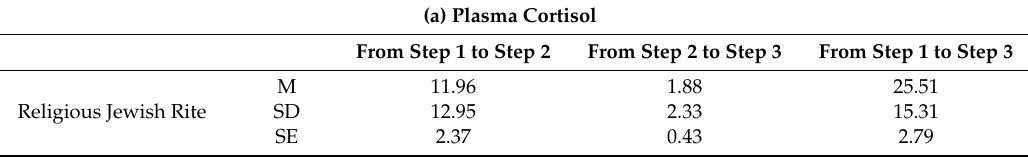
Table 2. Mean values (M), Standard Deviation (SD) and Standard Error (SE) of the increase rates among the three steps. M from step 1 to step 2 expresses the difference between the parameter recorded in steps 2 and 1, divided by the level found in step 1. M from step 2 to step 3 expresses the difference between the parameter recorded in steps 3 and 2, divided by the level found in step 2. M from step 1 to step 3 expresses the difference between the parameter recorded in steps 3 and 1, divided by the level found in step